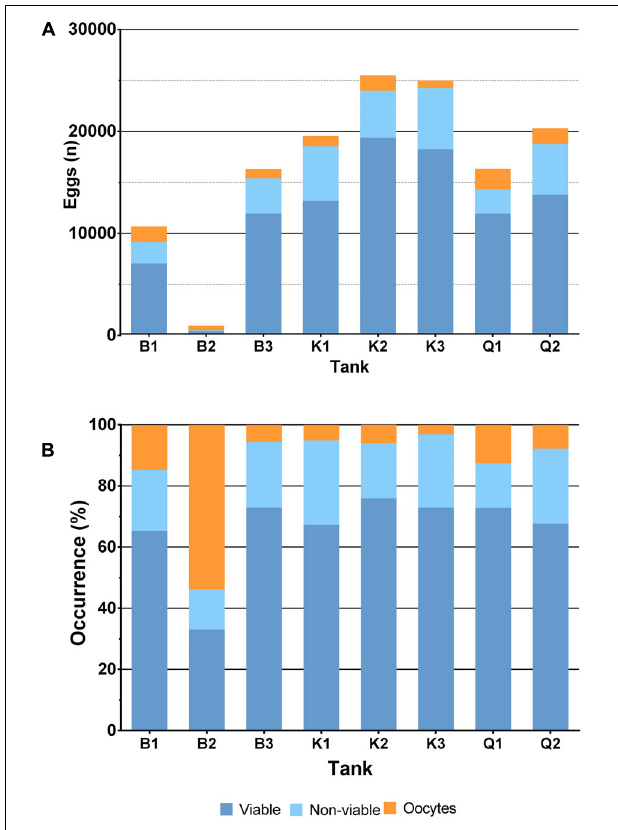
FIGURE 8 | Total amount (A) and percentage of occurrence (B) of eggs (viable and non-viable) plus oocytes (observed in post mortem females) obtained per